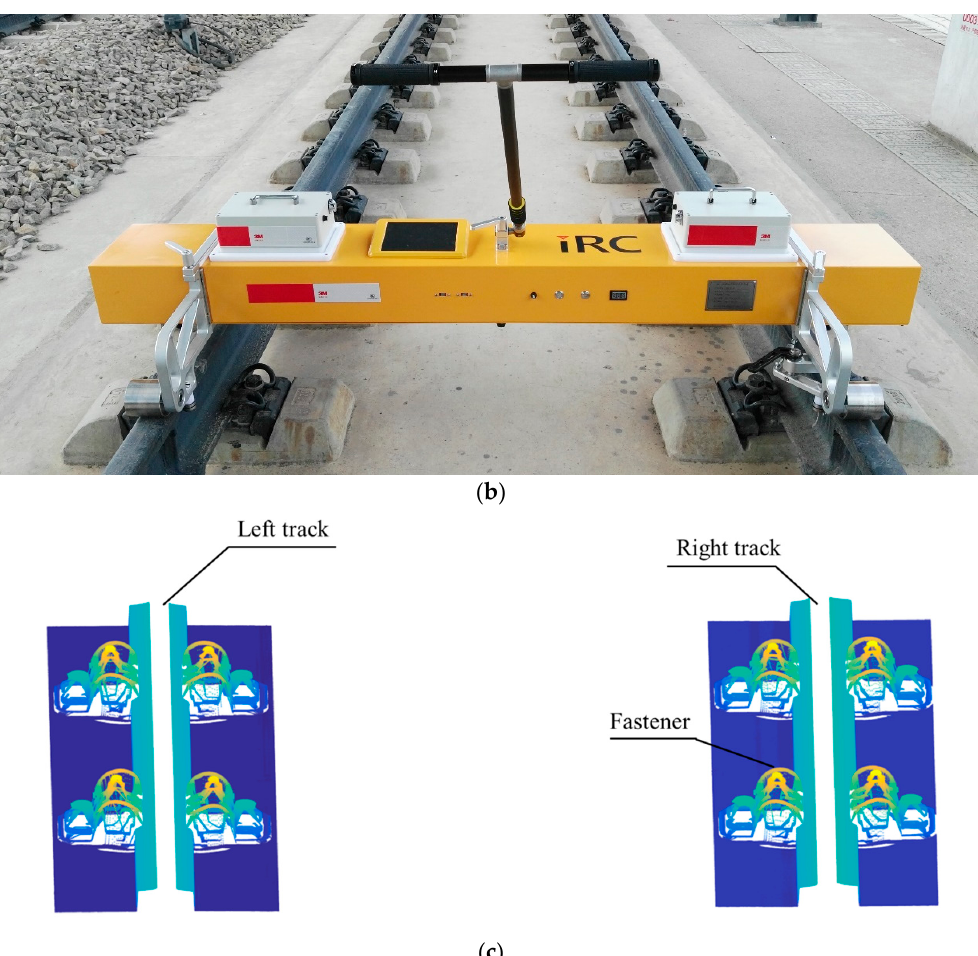
Figure 4. IRC system: ( a ) layout; ( b ) overview; ( c ) original output.